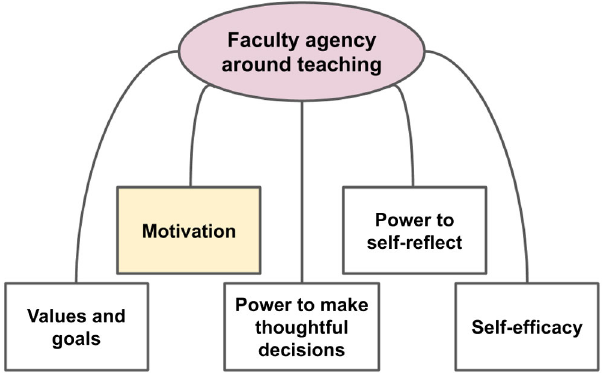
FIG. 3. Aspects of faculty agency around teaching, drawn from Bandura and articles on K-12 teacher agency [13,83 – 89]. In this paper, we focus on faculty motivation to develop as teachers.